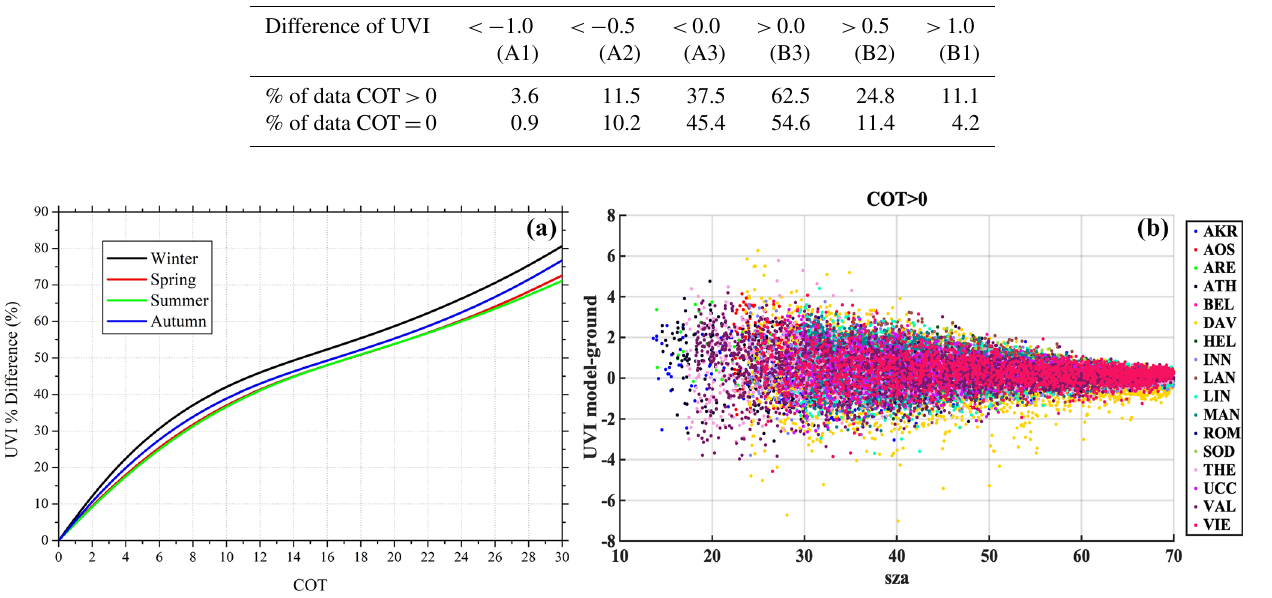
Figure 14. The average COT effect on UVI as a function of percentage difference for all seasons (a) and scatterplot of the UVI difference under cloudy-sky conditions for all stations (b)